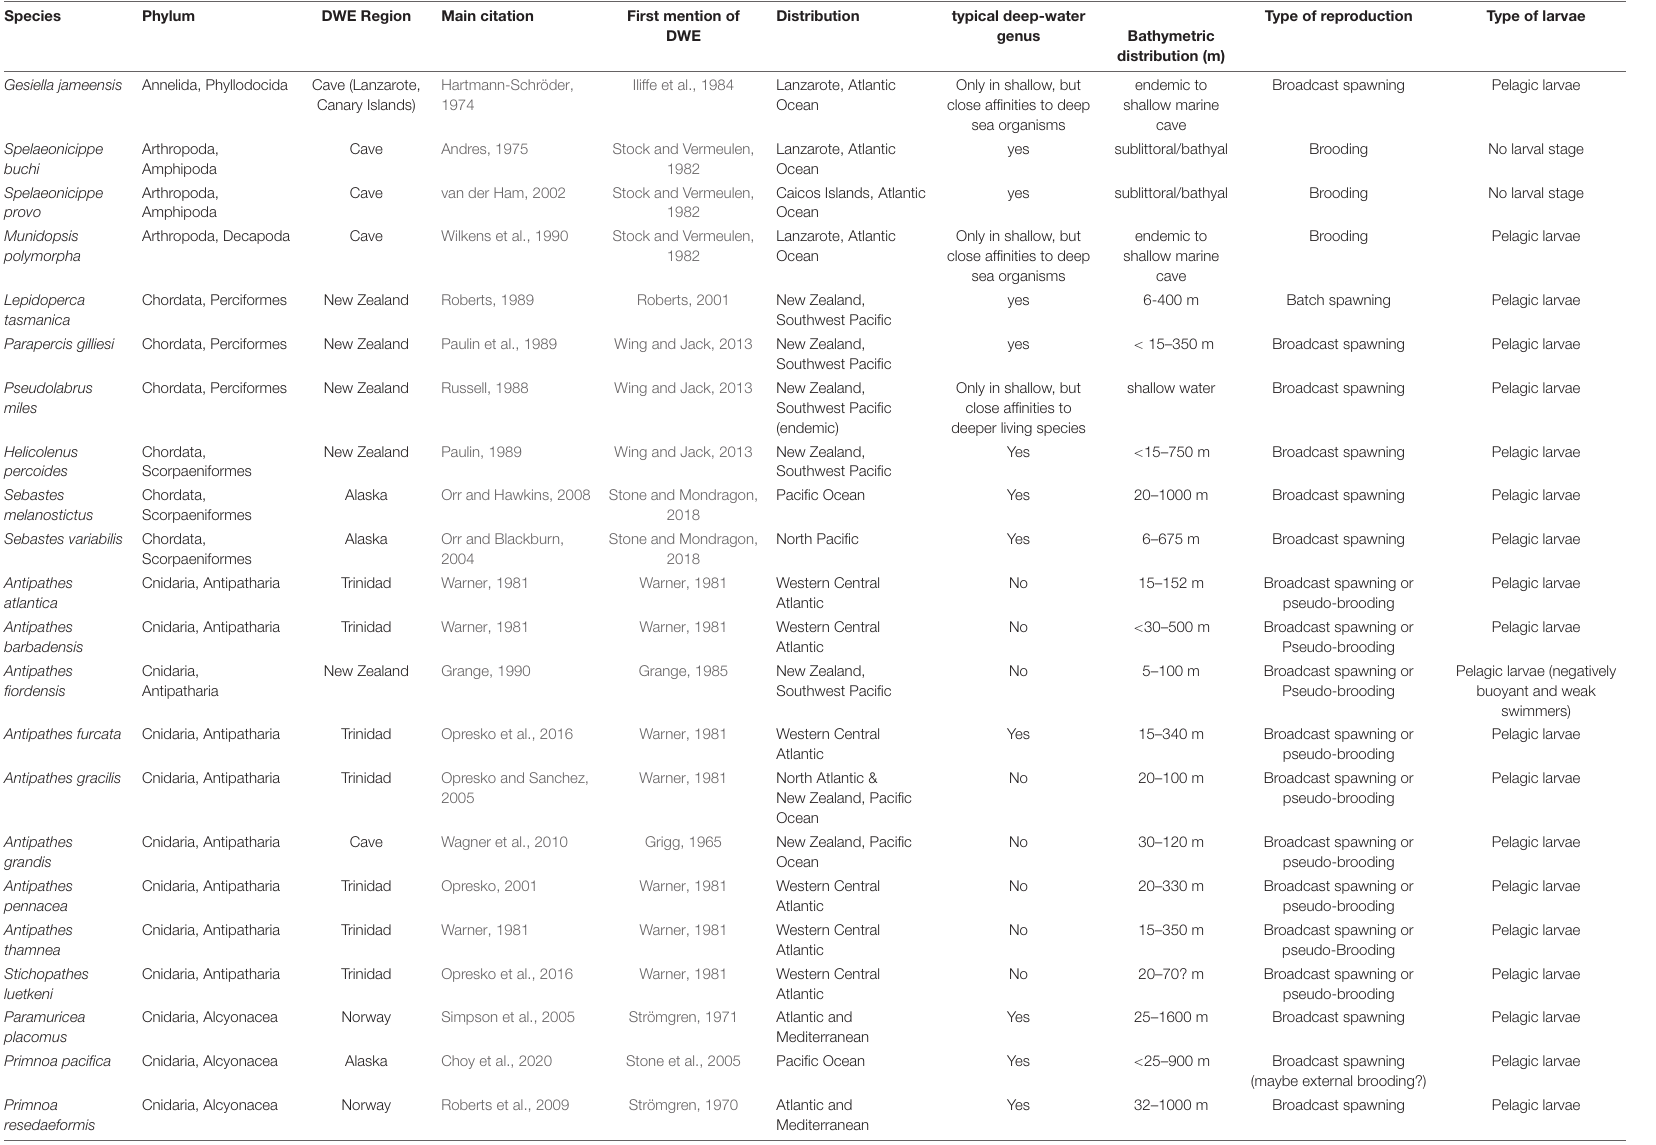
TABLE 3 | List of deep-water emergent species from other parts of the world: geographic and bathymetric distribution, main citation and first citation of deep-water emergence (DWE), typical deep-water species, type of reproduction and larvae.